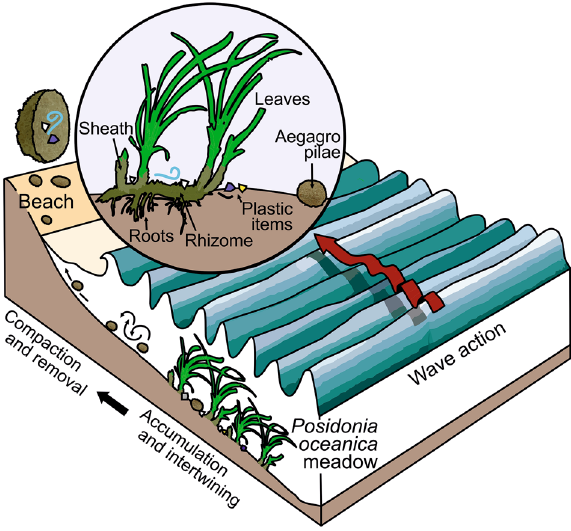
Figure 2. Trapping of plastic debris by seagrasses. Representation of the processes involved in the accumulation and intertwining of plastic items and sheath fibers to form plastic-rich aegagropilae (EG) found stranded in